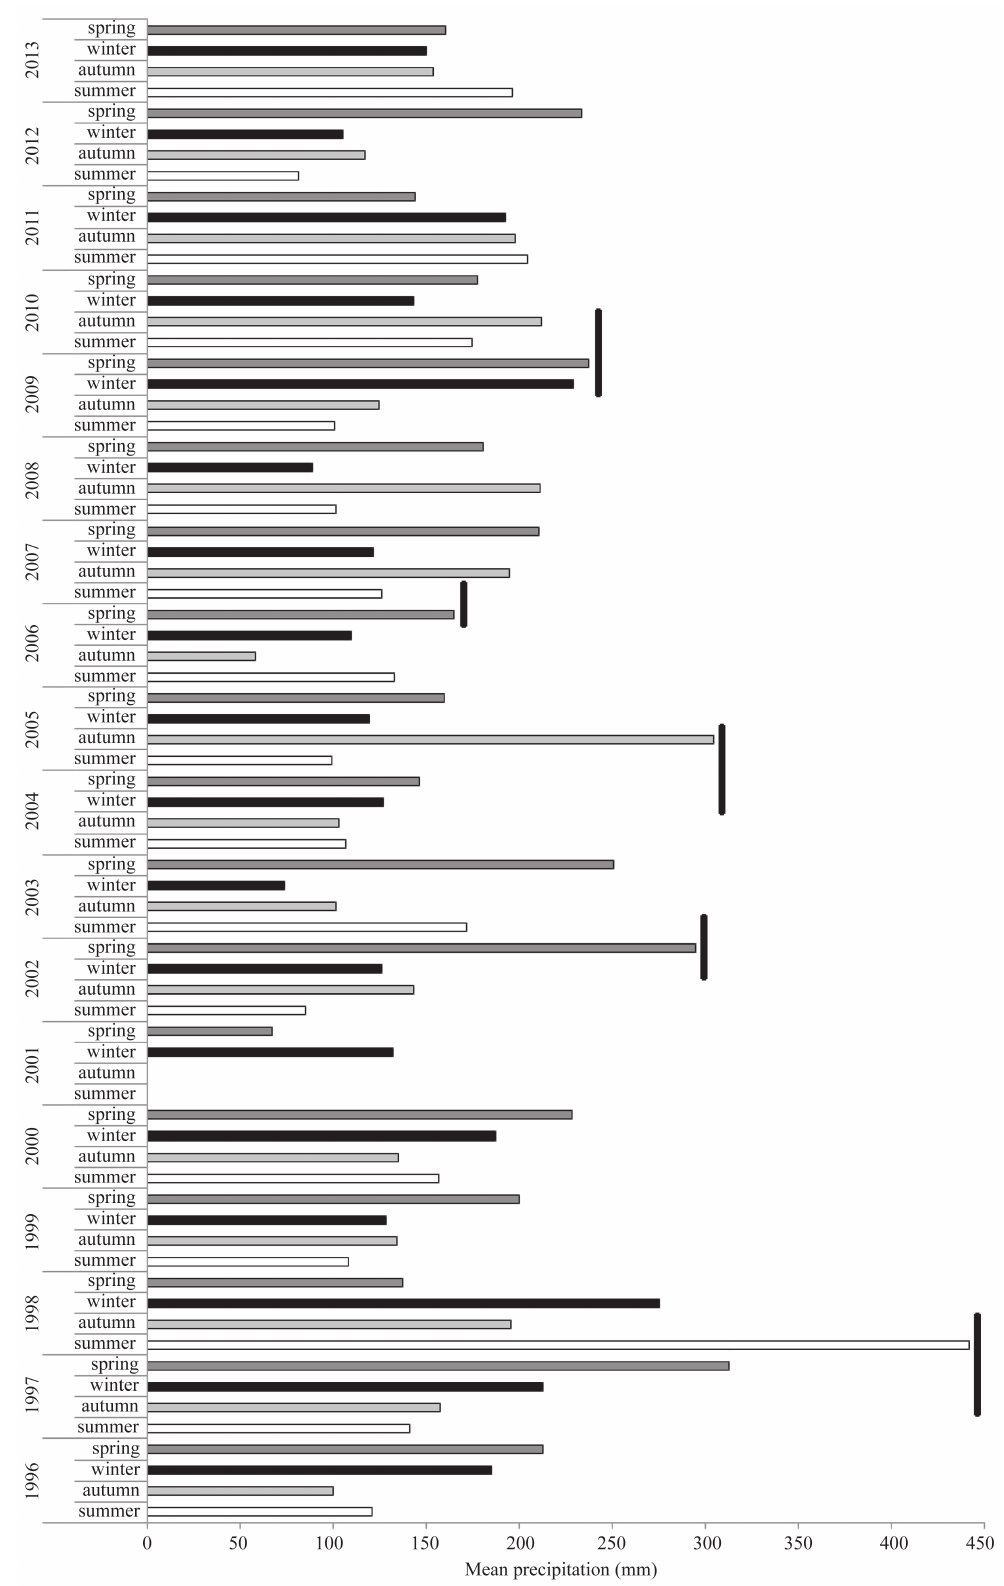
Fig. 1. Mean seasonal precipitation (mm) during the study period (1996-2013). Data obtained from the Meteorological Data Base for Teaching and Research/ National Institute of Meteorology (BDMEP/ IMET) from the Iraí Station. The vertical black bars indicates the occurrence of El Niño events ( 1997-1998, 2002-2003, 2004-2005, 2006-2007,